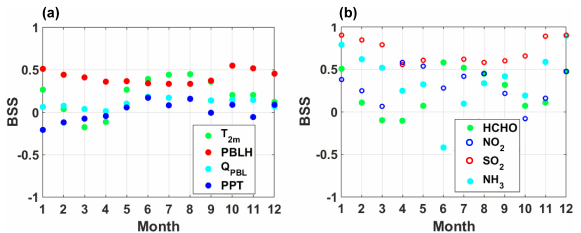
Figure 7. Brier skill scores (BSS) for key (a) meteorological and (b) chemical variables. BSS are computed using hourly data of T at 2m ( T 2m ) and PBLH, 3-hourly estimates of specific hu- midity in the boundary layer ( Q PBL ) and z scores of monthly total precipitation (PPT) and of monthly mean columnar gas-phase con-